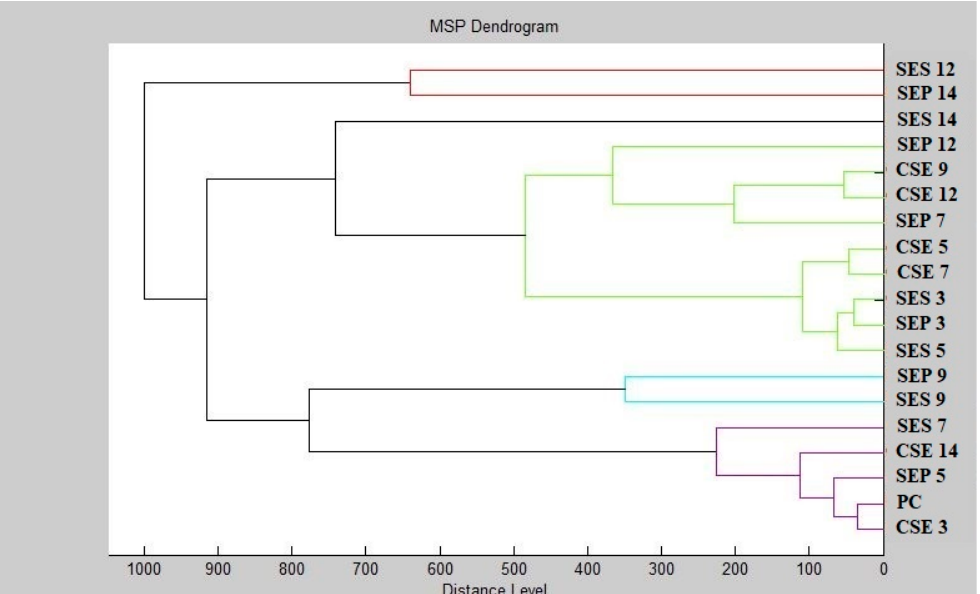
Figure 2. Dendrogram of S. enterica biofilm progress after CSEO exposition. SE– S. enterica ; C-control; S–stainless-steel; P-plastic; PC-planktonic cells.